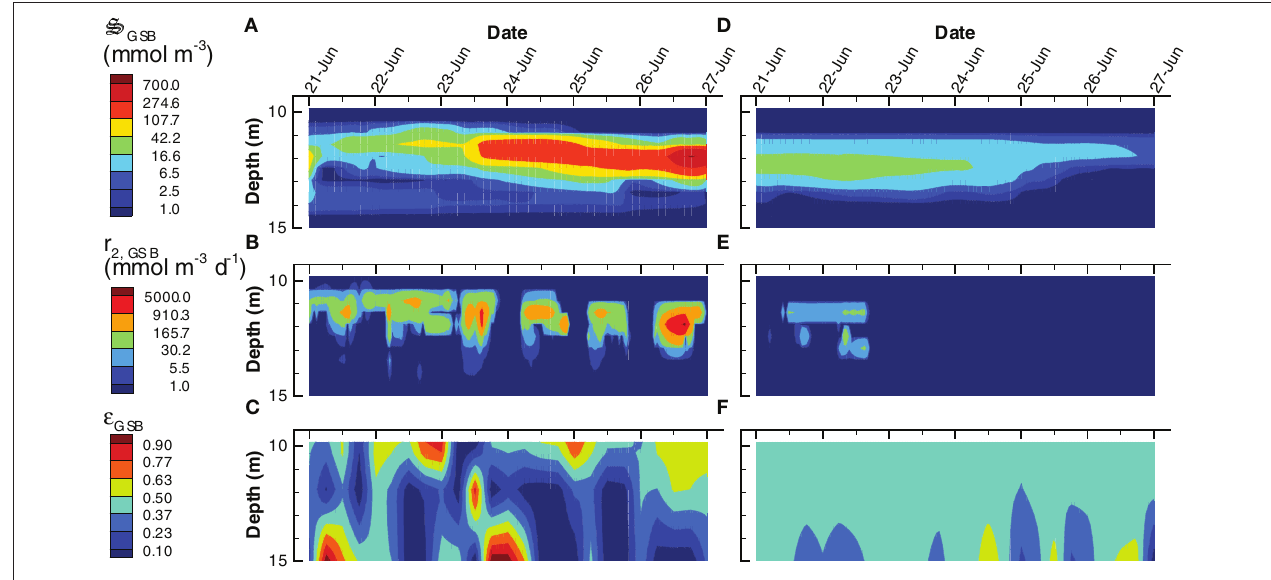
FIGURE 9 | Contour plots of green sulfur bacteria concentration, [ S GSB ] (A,D) , rate of the biosynthesis reaction, r 2, GSB (B,E) and the growth efficiency optimal control variable, ε GSB (C,F) for the SIO (A–C) and LIO (D–F) simulations. Note, variables are only plotted for 10m to 15m where the GSB are